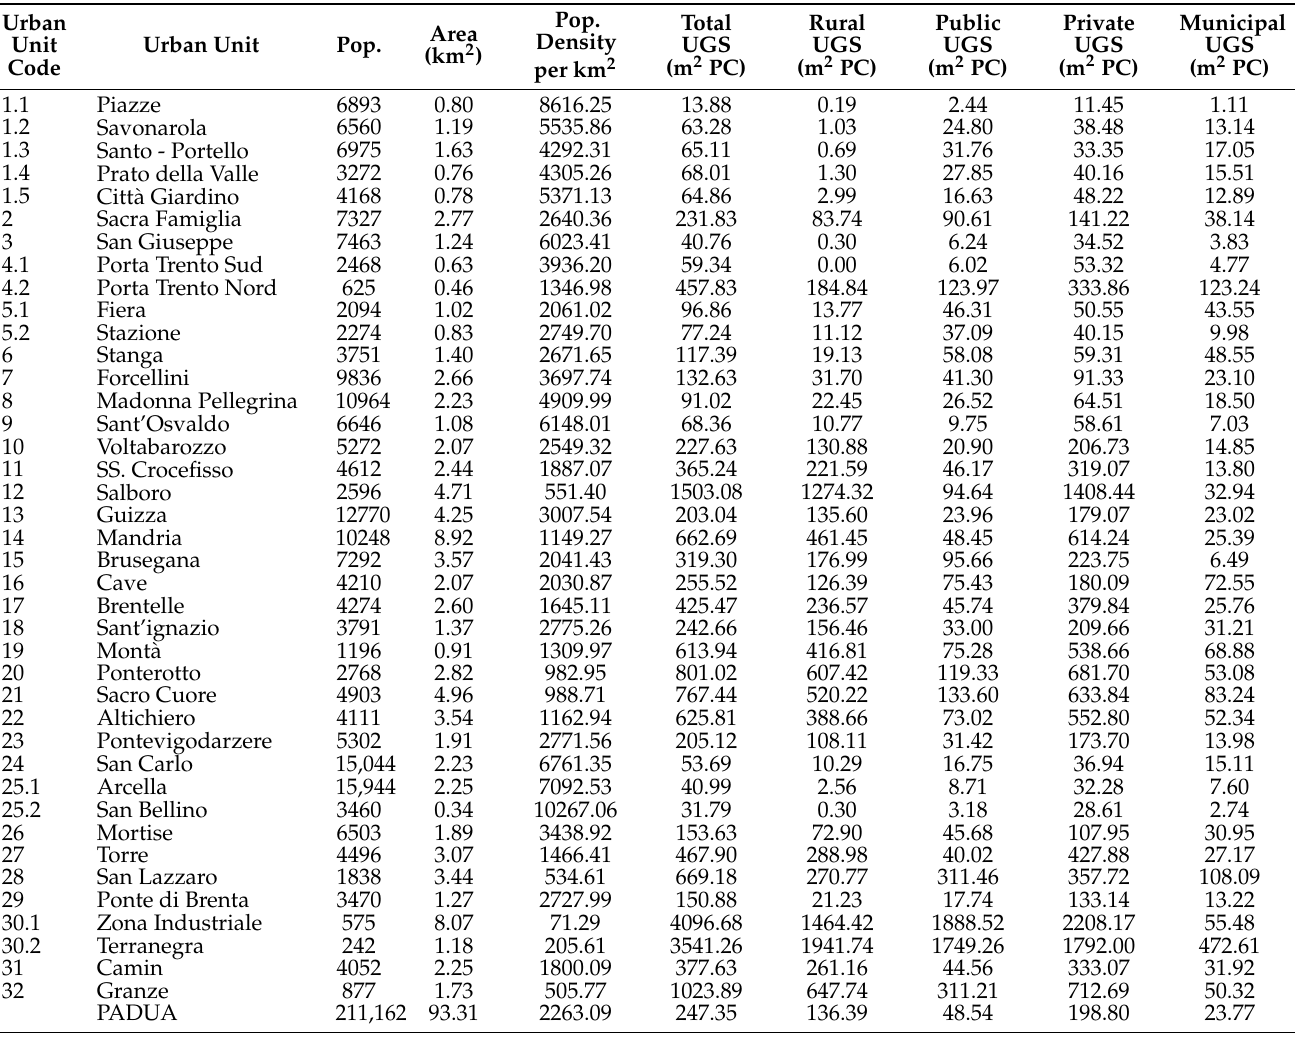
Table 11. Areas and per capita (PC) values of green space categories in the urban units of Padua. Urban